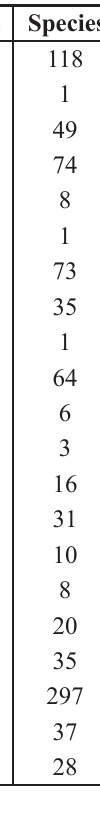
Table 3. Number of valid families, genera and species of fish from Portugal included in the checklist, according to Nelson’s (2006)